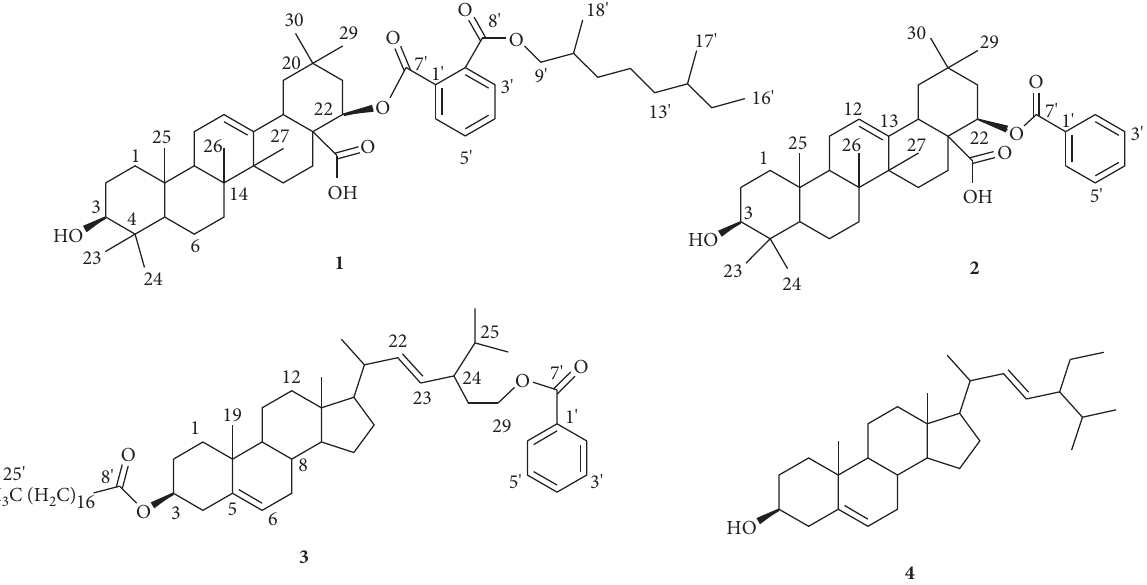
Figure 1: Structures of the isolated compounds from stem bark of A. gummifera